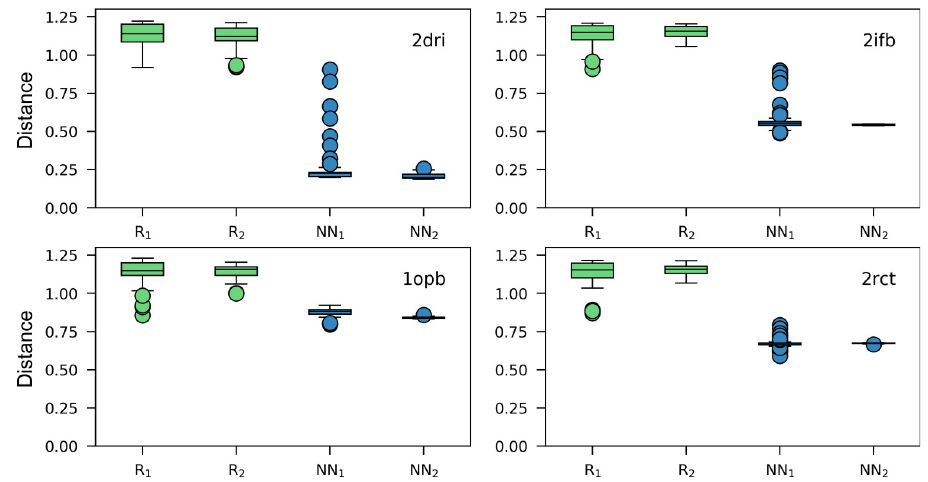
Fig 4. Amino acid frequency distributions for the outcome of the first and second half of design protocols. The boxplots represent the distributions of mean distances between amino acid frequencies tables ft k , pos , r related to the iterations of the NN-based protocol and a reference table ft GA from the GA-based protocol; compare Eq 3 and Eq 4. k ; pos contains the distributions related to the first 50 and NN k the distributions of the second 50 iterations. The group NN k 1 2 For the computation of R k and R k , the values of each table ft NN were shuffled; for details see Materials and methods. 1 2 k ; pos ; r The boxplots show the results for the four designs with the set repr_prot